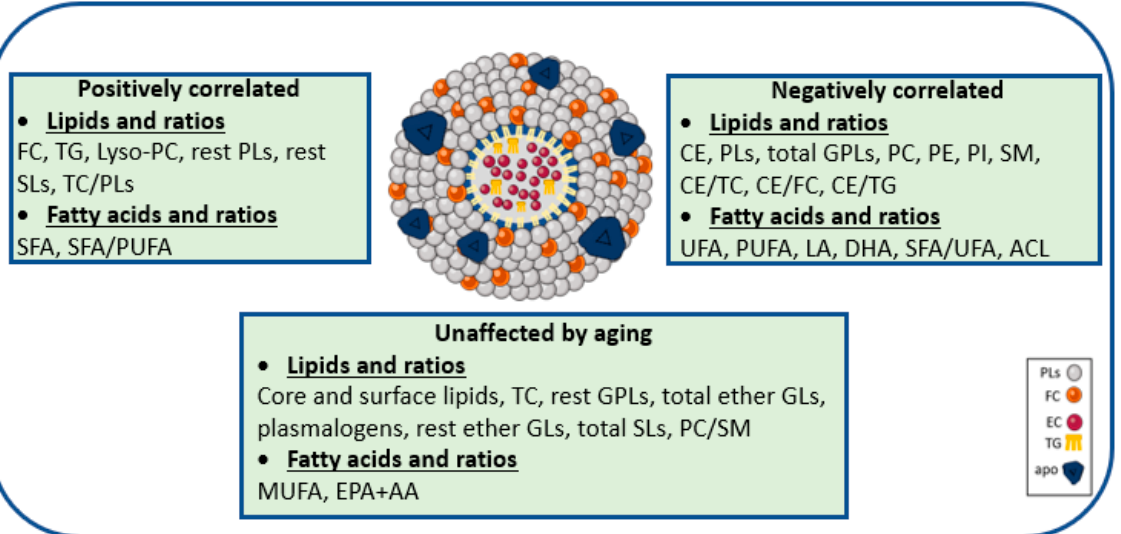
Figure 1. HDL lipidome and fatty acids positively or negatively correlated, or unaffected by aging.